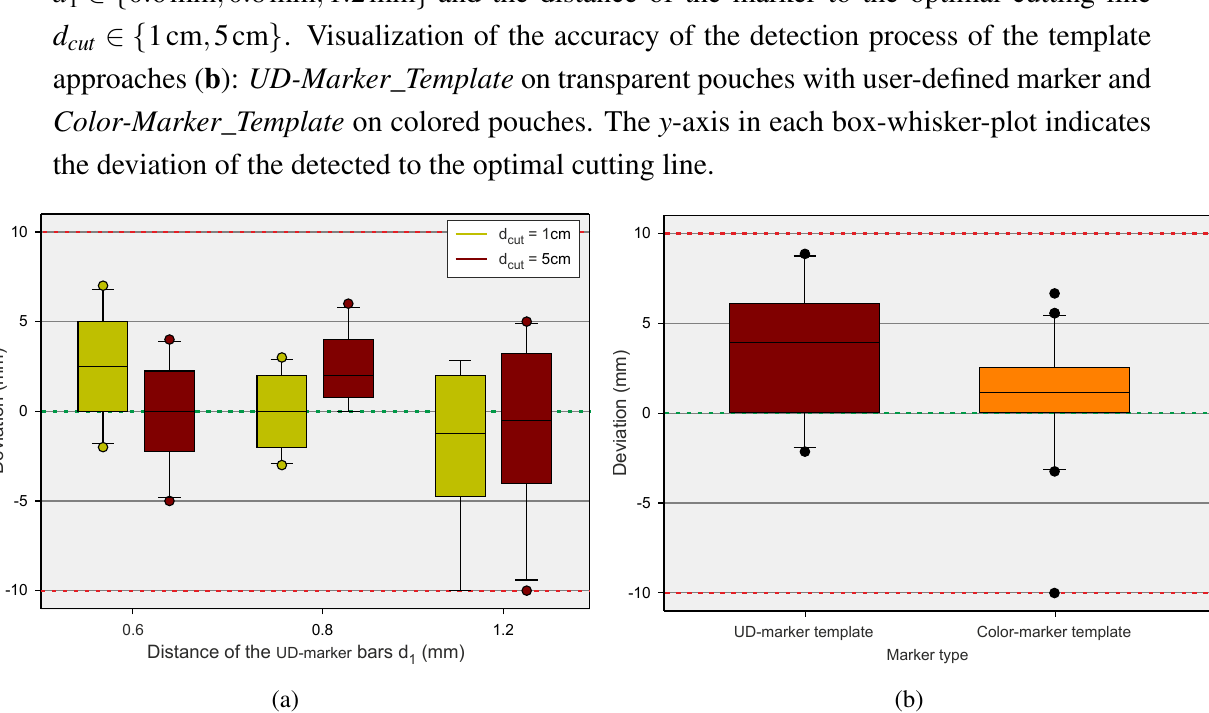
Figure 23. Accuracy of the detection process with UD-Marker_SVM on ( a ) transparent